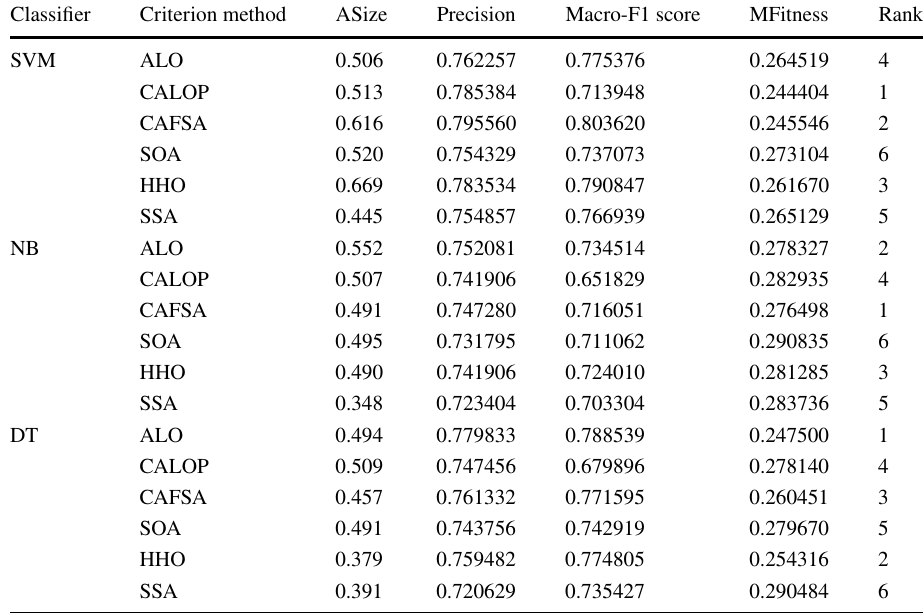
Fig. 13 Comparison of different feature selection algorithms on SoGouCS